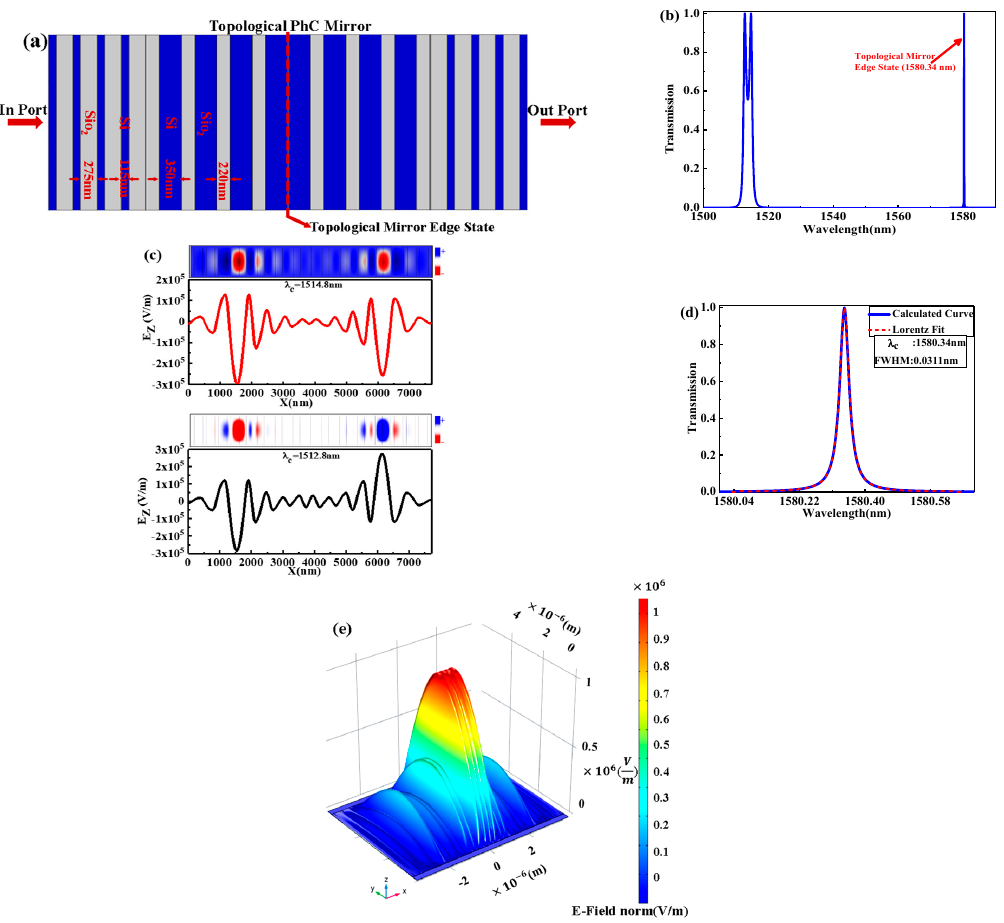
Figure 3. ( a ) Schematic diagram of the proposed 1D topological PhC mirror heterostructure; ( b ) the transmission spectrum of the topological PhC mirror heterostructure; ( c ) the calculated electric field E of z component in 1D topological PhC mirror heterostructure with mode symmetry; ( d ) The zoom-in of the sharp peak of the topological mirror edge state and the dashed line shows the fitting curve, which is symmetric, in the typical Lorentzian-line shape with 100% transmittance at central wavelength 𝜆 (cid:3030) = 1580.34 nm and 𝐹𝑊𝐻𝑀(Δ𝜆) = 0.0311 nm ; ( e ) the electric field distribution in which the elec- tric field is highly localized around zero point is exactly located at the interface point between the two topological PhCs at a central wavelength 𝜆 (cid:3030) = 1580.34 nm .